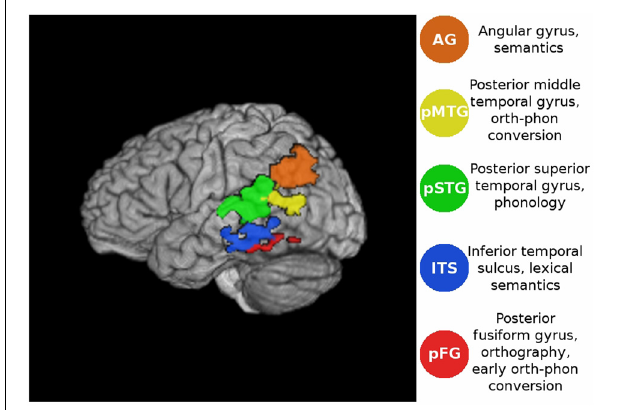
FIGURE 1 | Volume rendering of the functional ROIs in the lateral view of the atlas brain. For coordinates see Table 1 .